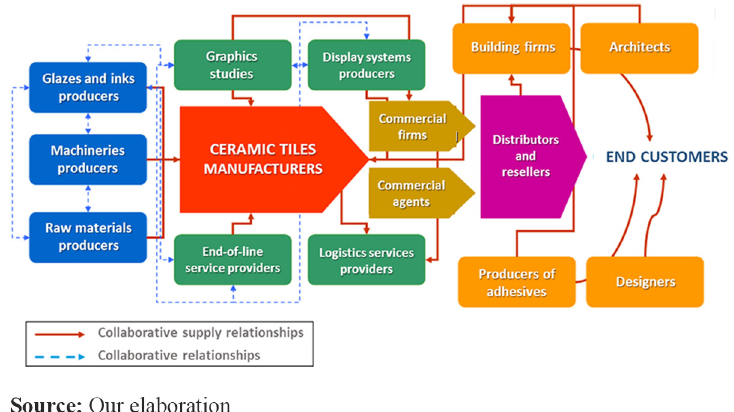
Figure 1. Supply chain of